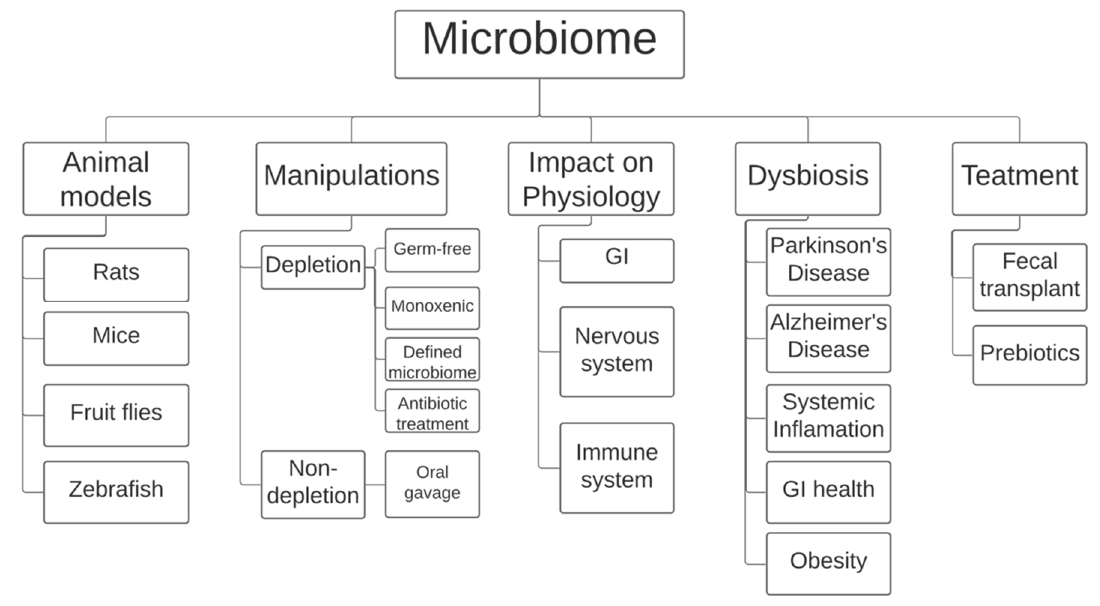
Figure 1. Currently, the field of microbiome research employs rodents (mice and rats), the fly Drosophila melanogaster, and the fish zebrafish as animal models. Most manipulations involve either complete/partial depletion of the microbiome using specific rodent models or microbiome transplants using oral gavage. Research has shown that the microbiome is heavily involved in improper development of the gastrointestinal tract and the nervous and immune systems. A link has also been made between imbalances in the gut microbiome, also known as dysbiosis, and certain diseases, including Parkinson’s and Alzheimer’s disease and obesity, among others. Gut dysbiosis is currently treated in humans using prebiotics and/or fecal transplants. GI: gastro-intestinal tract.